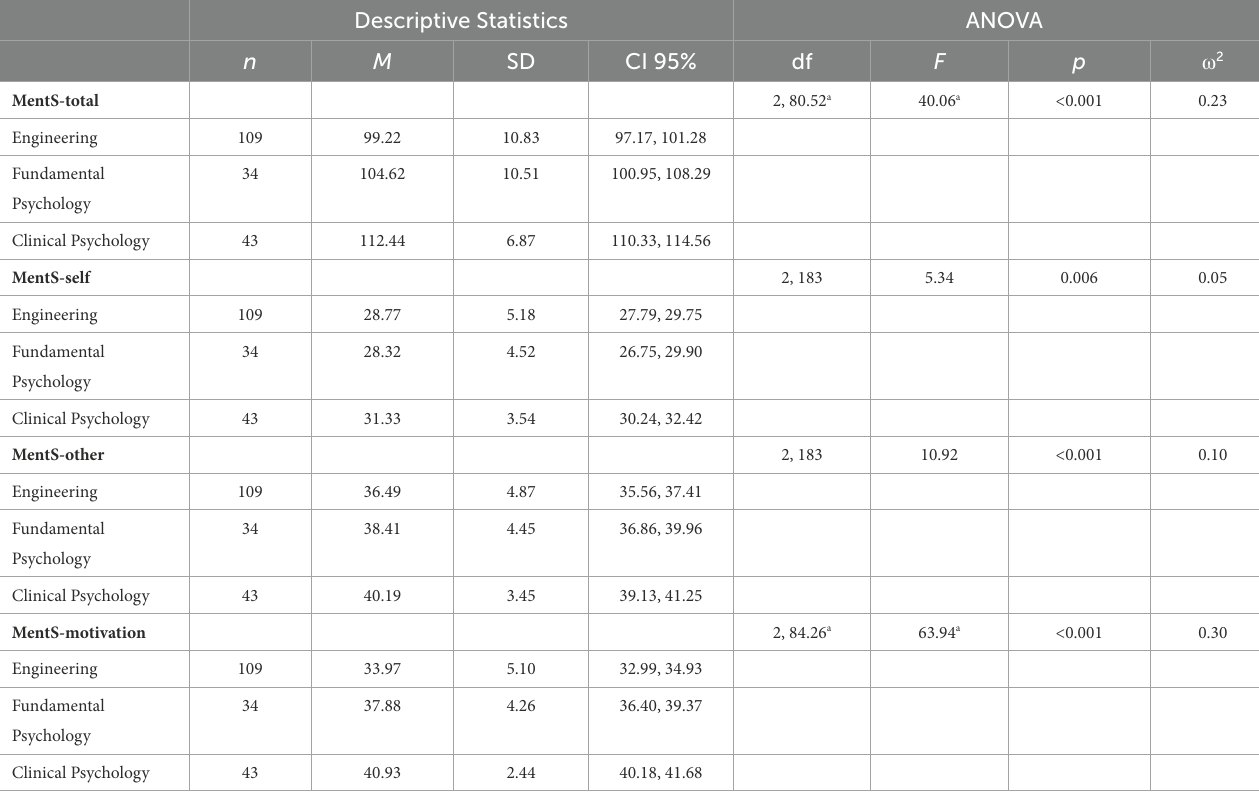
TABLE 4 ANOVA by study group first year